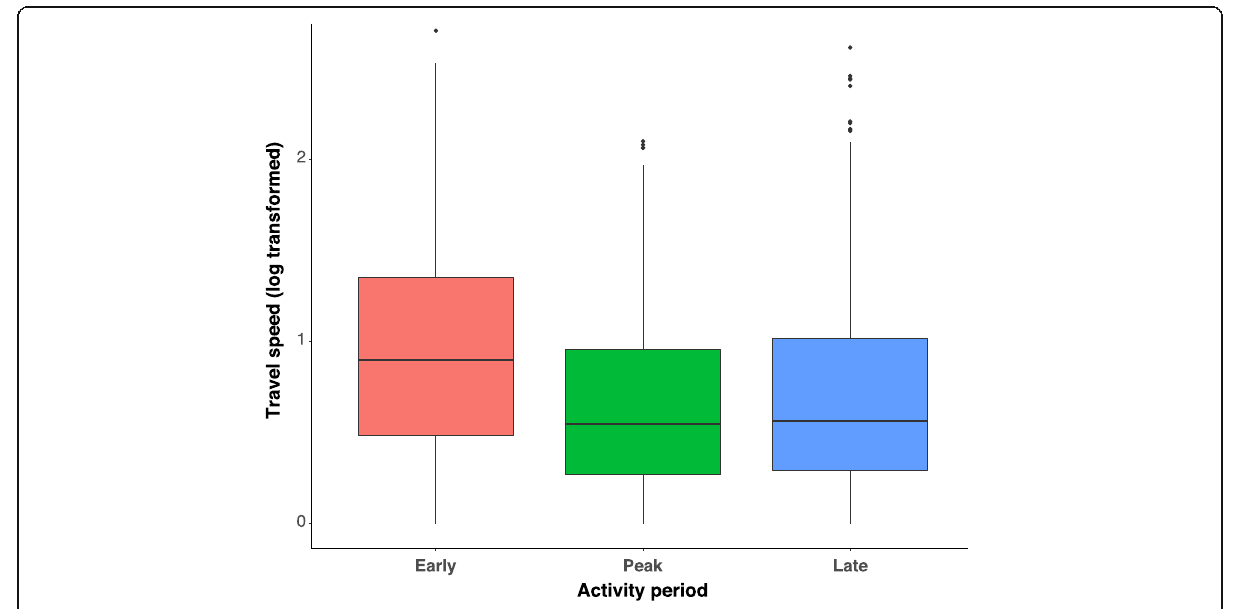
Fig. 1 Travel speed (m / min) during the early (19:00 to 01:00 h), peak (01:00 to 03:00h), and late (03:00 to 07:00 h) activity